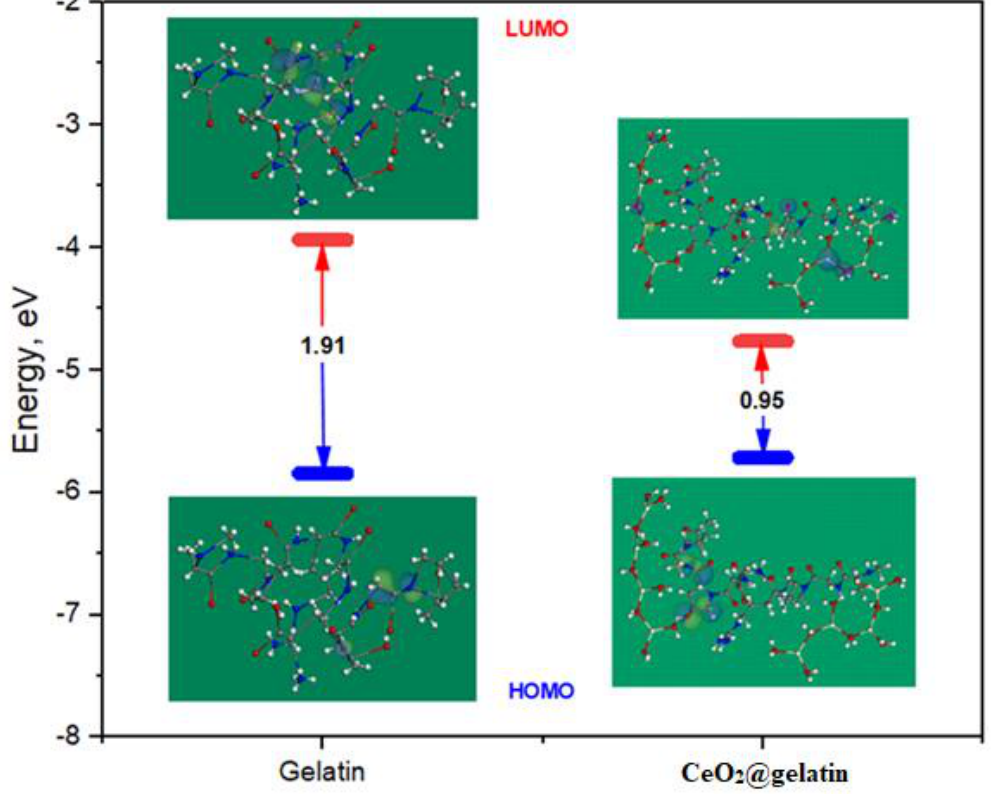
Figure 12. Energy diagram of the frontier molecular orbitals for the gelatin and CeO 2 @gelatin molecule using the DFT method.